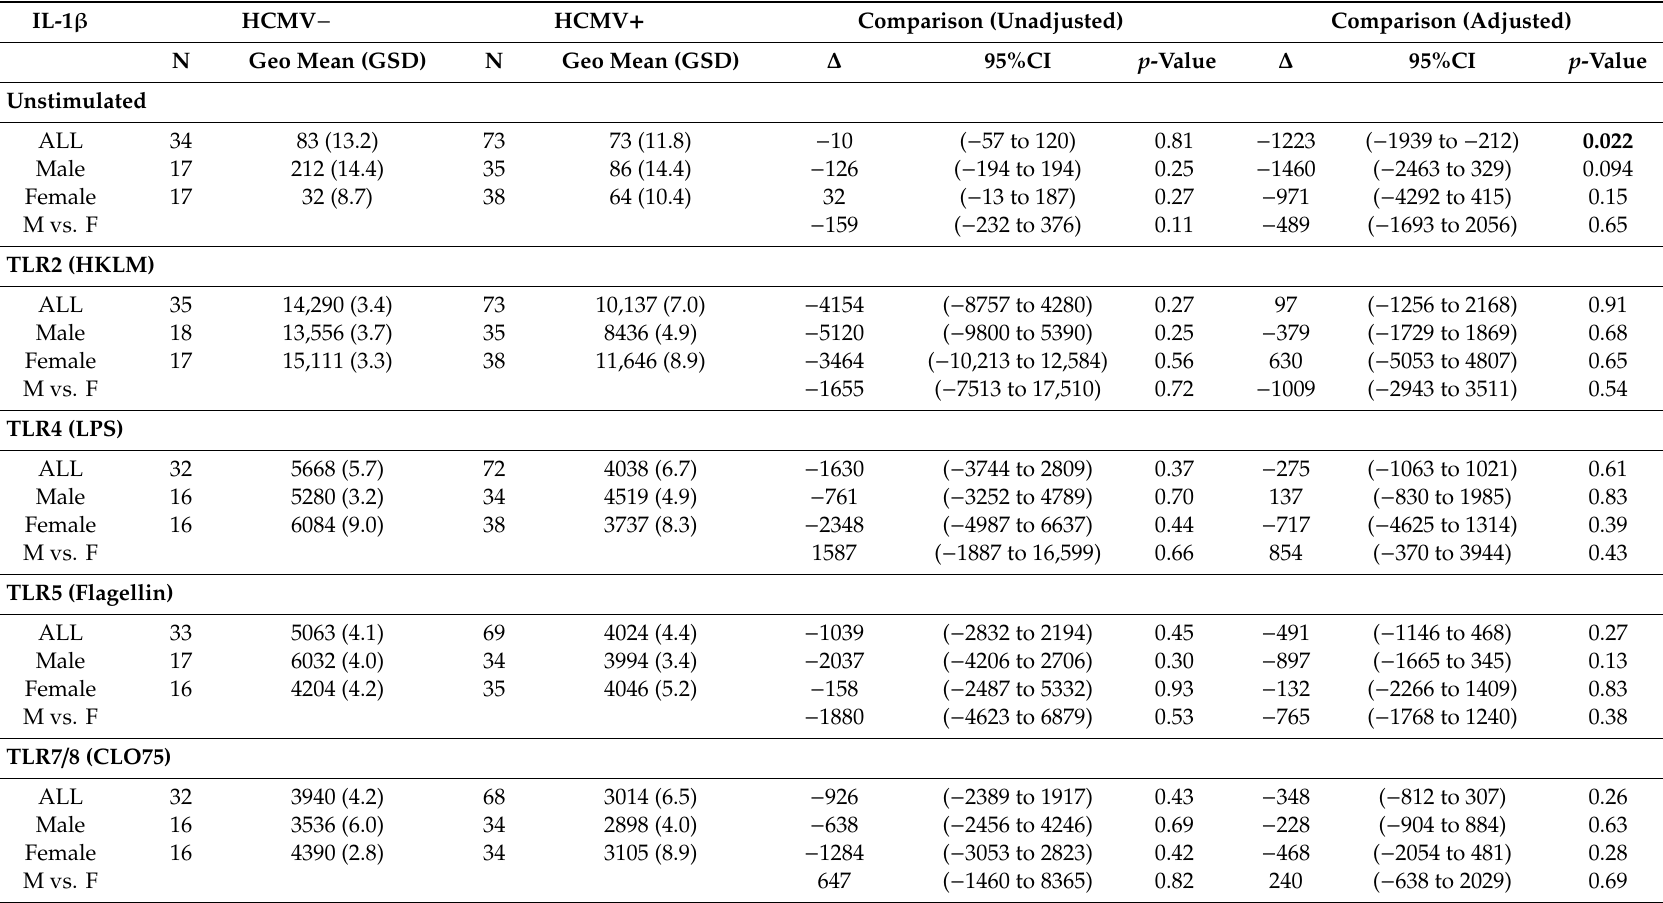
Table 3. E ff ect of HCMV infection on TLR ligand-stimulated IL-1 β responses by infant